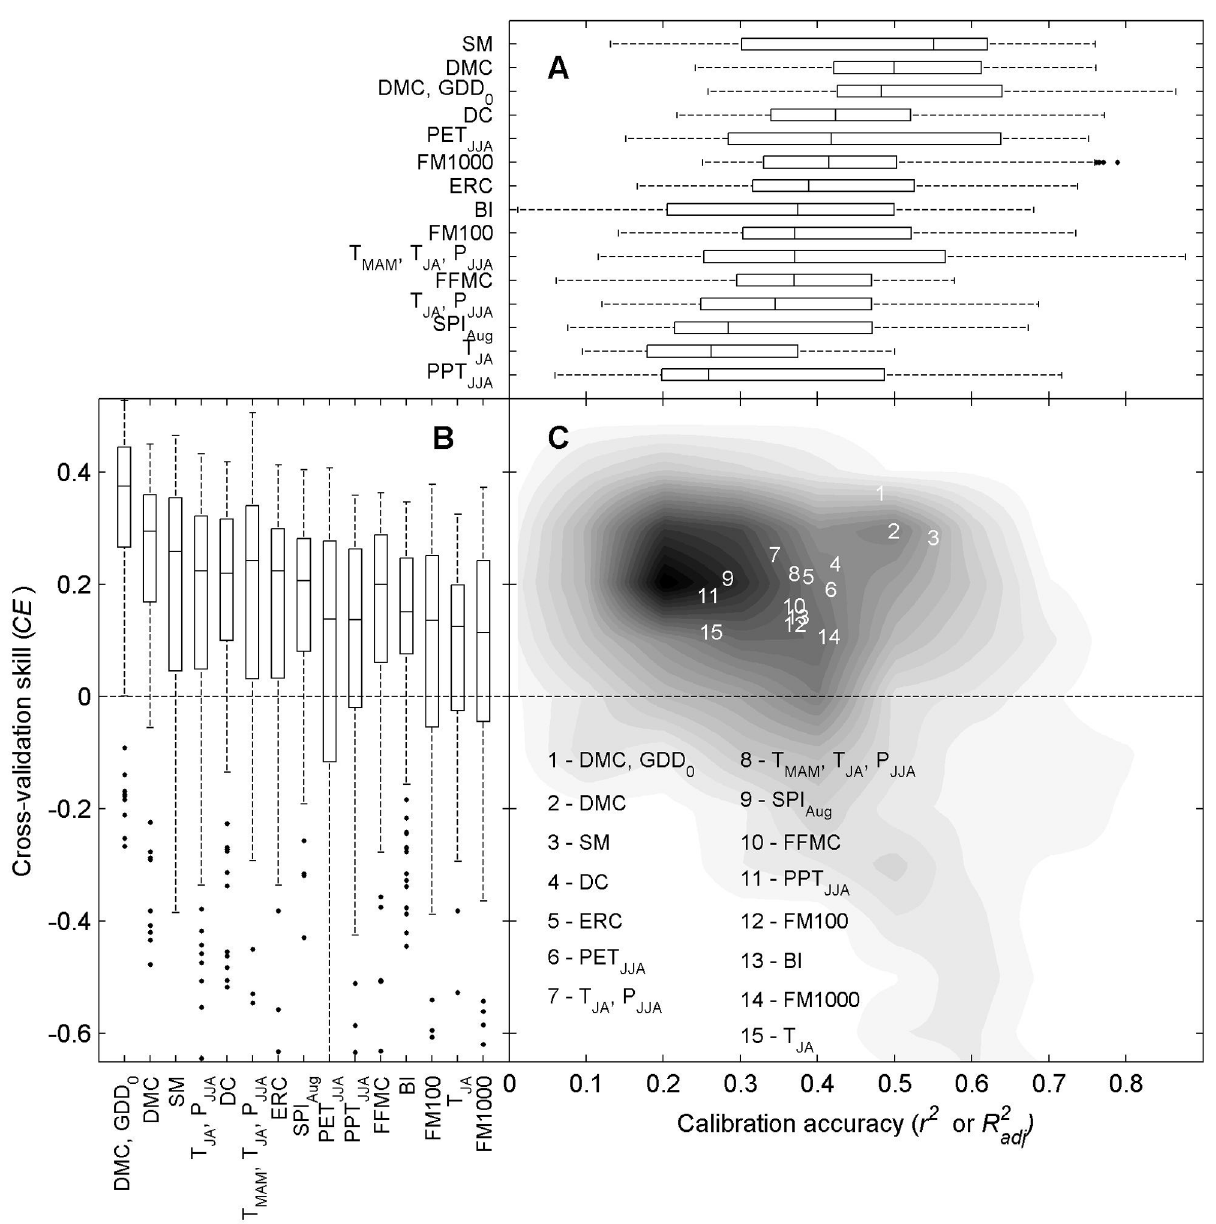
Fig 4. Calibration accuracy and cross-validation skill of potential predictors of annual area burned. (A) Accuracy ( r 2 or R 2 adj ) from the 87 continuous 21-yr regression models. Metrics are ranked (top to bottom) based on the median value. Boxplots display the median, 25 th , and 75 th quantiles, and whiskers extend to extreme values not considered outliers. (B) Cross-validation skill, CE , for all 87 cross-validation periods. Metrics are ranked from left to right based on the median value; CE (cid:3) 0 indicates no predictive skill. (C) Calibration accuracy as a function of cross-validation skill, where darker grey indicates a greater proportion of values. Overall metric rank (i.e., CE * r 2 or R 2 adj ) is indicated by the within-plot